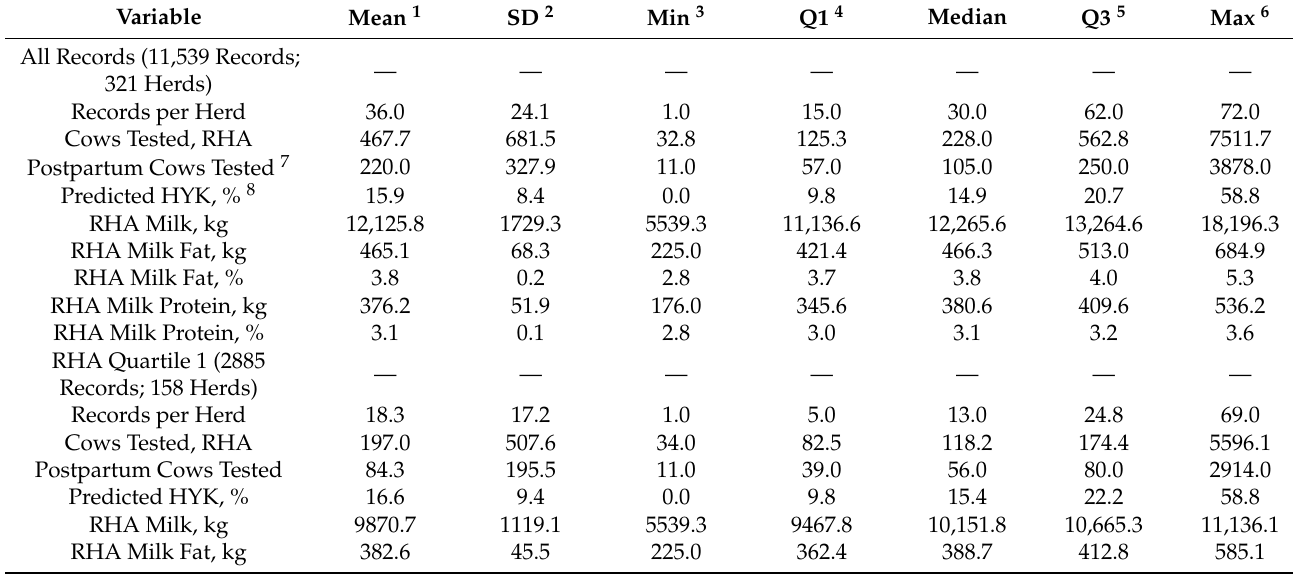
Table 2. Overall and Rolling Herd Average (RHA) Quartile Descriptive Statistics of Herds Providing Test Day